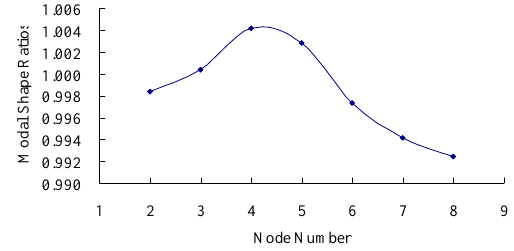
Fig. 5. Modal shape ratios between before and after damage